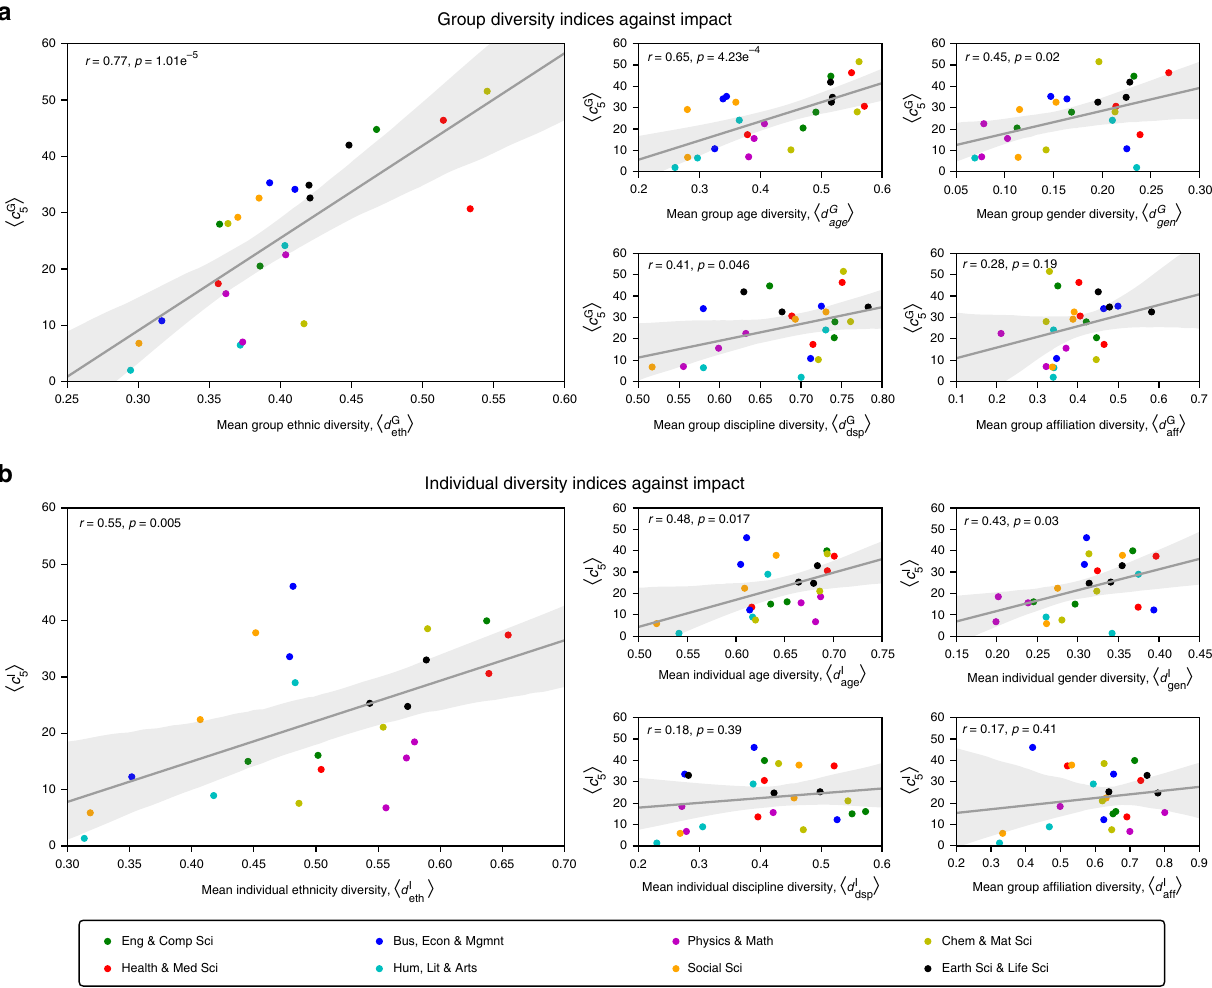
Fig. 3 Group and individual diversity vs. impact in each sub fi eld. In each subplot, the points correspond to sub fi elds, the color indicates the main fi eld, while the solid line and the shaded area represent the regression line and the 95% con fi dence interval, respectively. Each regression has also been annotated with the corresponding Pearson ’ s r and p values. a For each sub fi eld, the subplots depict the mean group diversity indices, h d G h d G i , against the mean 5-year citation count, h c G 5 i , taken over papers in that sub fi eld. b For each sub fi eld, the subplots depict the mean individual diversity aff indices, h d I i , h d I i , h d I i , h d I i and h d I i , against the mean 5-year citation count, h c I 5 i , taken over scientists in that sub fi age gen eth dsp aff